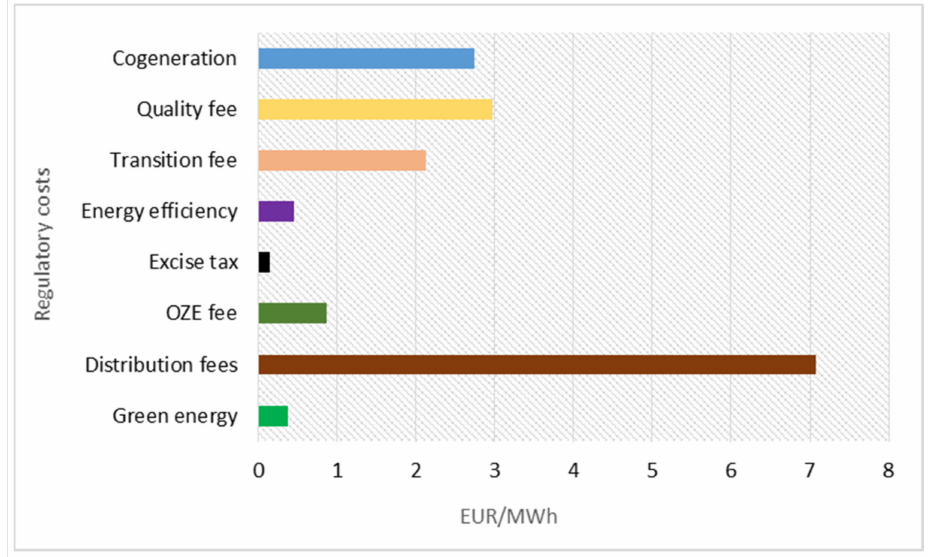
Figure 9. Regulatory costs incurred by steel mills in Poland by item. Source: own elaboration based on